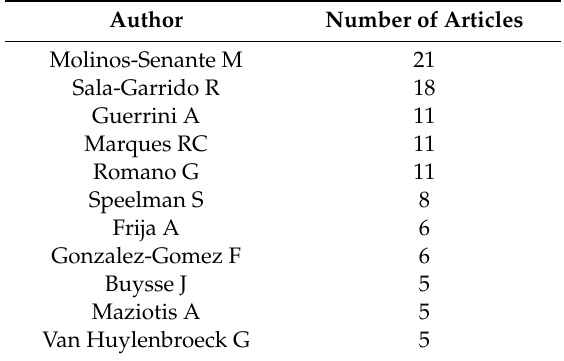
Table 1. Most productive authors (with at least 5 publications).